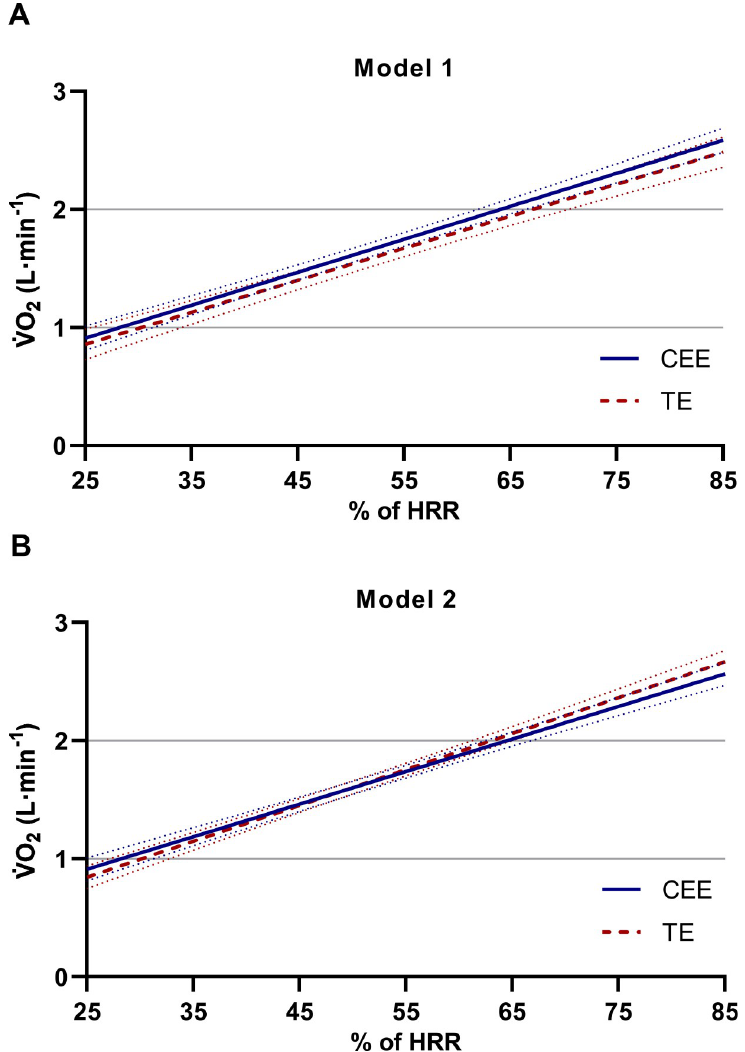
Fig 2. Estimated mean _ V _ O levels between 25–85% of HRR in cycle ergometer exercise (CEE) and treadmill 2 exercise (TE) in model 1 and model 2. Based on all participants (n = 34) individual values. CEE: blue solid line. TE: red dashed line. The linear regression equations with 95% CI and r-coefficients were: Model 1 (A) y( _ V _ O CEE) = 0.210 2 (0.042 ─ 0.377) + 0.0279(0.0251 ─ 0.0308) � x(%HRR), r-coefficient = 0.781, y( _ V _ O TE) = 0.178(-0.030 ─ 0.386) + 0.0271 2 CEE) = 0.222(0.064 ─ 0.380) + 0.0276 (0.0236 ─ 0.0307) � x(%HRR) and r-coefficient = 0.700. Model 2 (B) y( _ V _ O 2 (0.0249 ─ 0.0303) � x(%HRR), r-coefficient = 0.795, y( _ V _ O TE) = 0.084(-0.072 ─ 0.241) + 0.0304(0.0277 ─ 0.0331) � x(% 2 HRR) and r-coefficient = 0.825. Issues of optimization of the HR method protrude when moving the focus from effects on mean values (cf. Fig 2) to effects on individual values (cf. Figs 3 and 4). It is notable that the deviances between the two exercise modalities are generally greater in model 1 than in model 2 (Fig 3 hin and 3B). Thus, the differences between CEE and TE seem to be reduced when the maximal workloads are added to the HR (cid:0) _ VO relationships. Interestingly, when comparing 2 model 1 with model 2 within CEE, in contrast to TE, the values are well aligned along the line of identity (cf. Fig 4A and 4B). Thus, the HR method in CEE, in itself, does not gain anything through adding maximal exercise. Thereby it cannot explain the reduction in spreading when